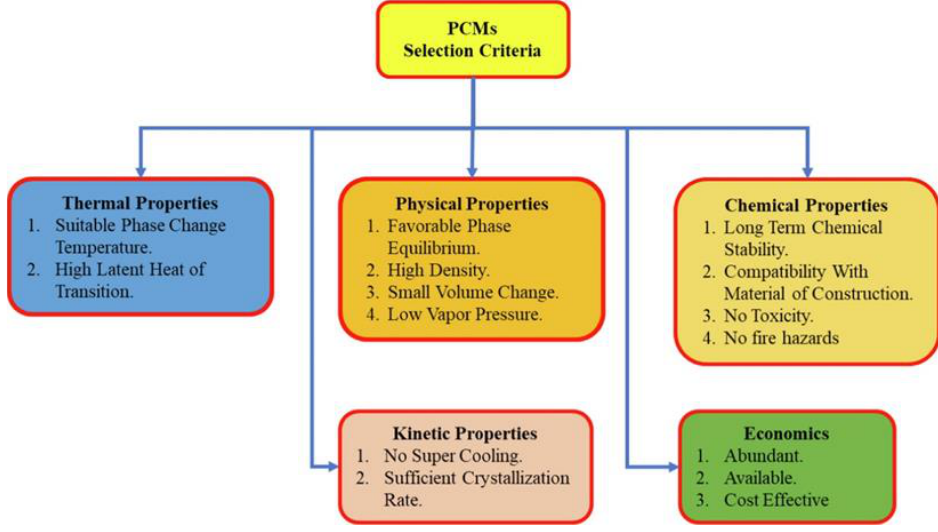
Figure 5. Various criteria for the selection of PCM [71].